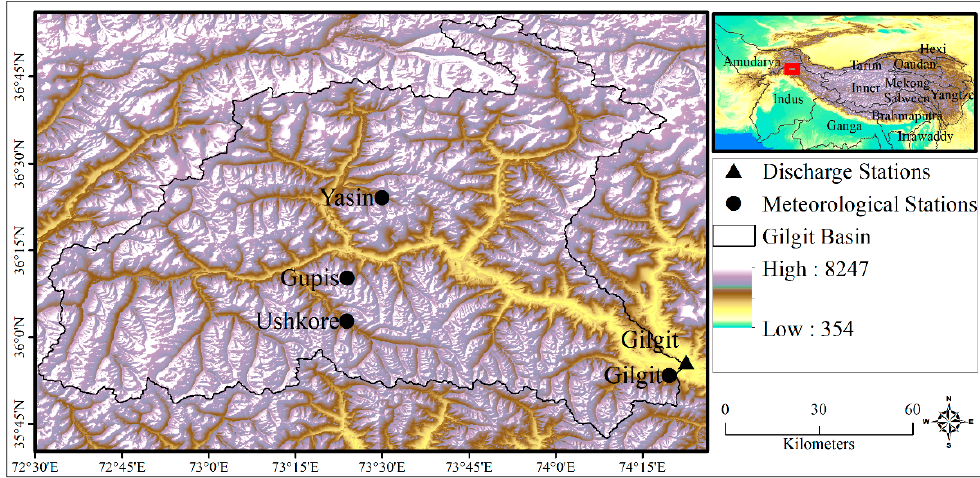
Figure 1. Study area map featuring Gilgit River Basin and major neighboring basins of Asia.